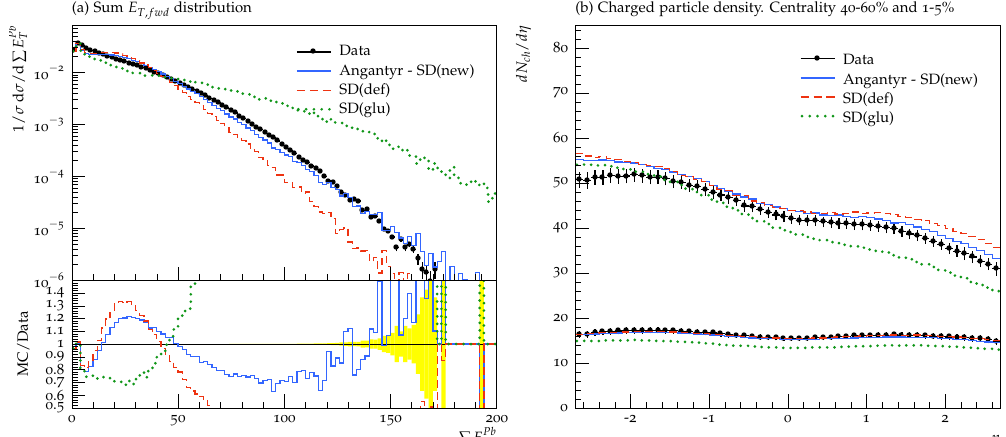
Figure 24 . Same as (cid:12)gure 23, but comparing di(cid:11)erent choices in the treatment of secondary absorptive interactions. The lines corresponds to the models in (cid:12)gure